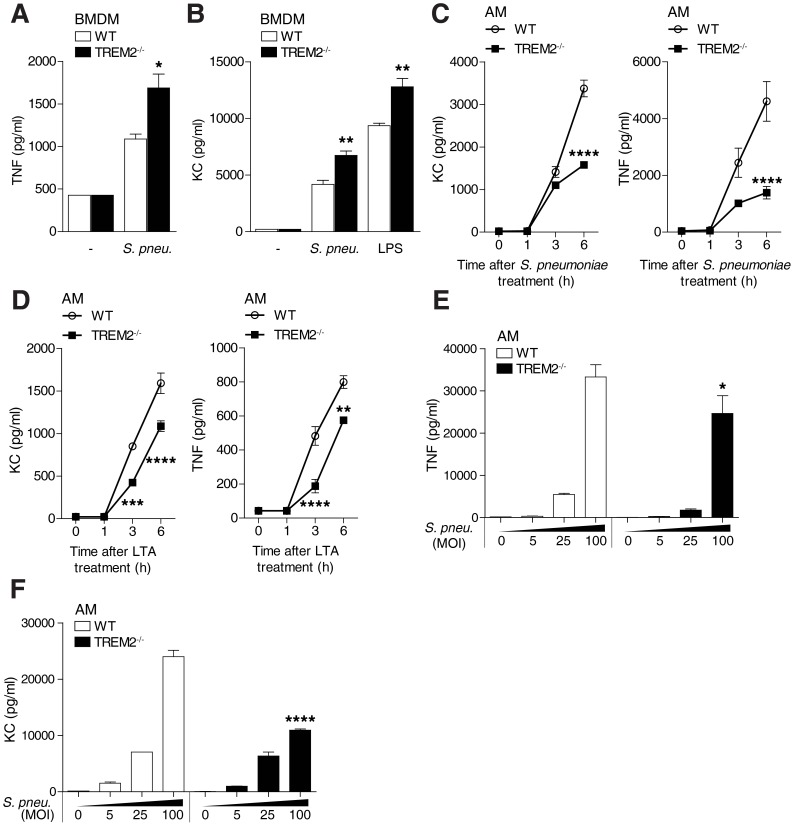
Cell type specific effects of TREM-2 on S. pneumoniae and TLR2 mediated cytokine production.(A–B) WT and Trem-2
−/− BMDM (n = 4 per genotype) were treated with 2×107 CFU/ml S. pneumoniae or 100 ng/ml LPS for 6 h and TNF-α (A) or KC (B) levels were measured in the supernatant. (C–D) WT and Trem-2
−/− AM (n = 4 per genotype/time point) were treated with 2×107 CFU/ml S. pneumoniae (C) or 10 µg/ml S. pneumoniae LTA (D) for the indicated times and KC and TNF-α levels were measured in the supernatant. (E–F) WT and Trem-2
−/− AM (n = 4 per genotype/MOI) were treated with the indicated doses of S. pneumoniae and TNF-α (E) and KC (F) levels were determined in the supernatant. Statistical comparisons are done versus WT cells (A–B) at a given timepoint (C–D), or at a particular MOI of S. pneumoniae (E–F), and indicated as: * p<0.05, ** p<0.005, *** p<0.001, **** p = <0.0001. All data represent mean ± SEM and are representative of two independent experiments.